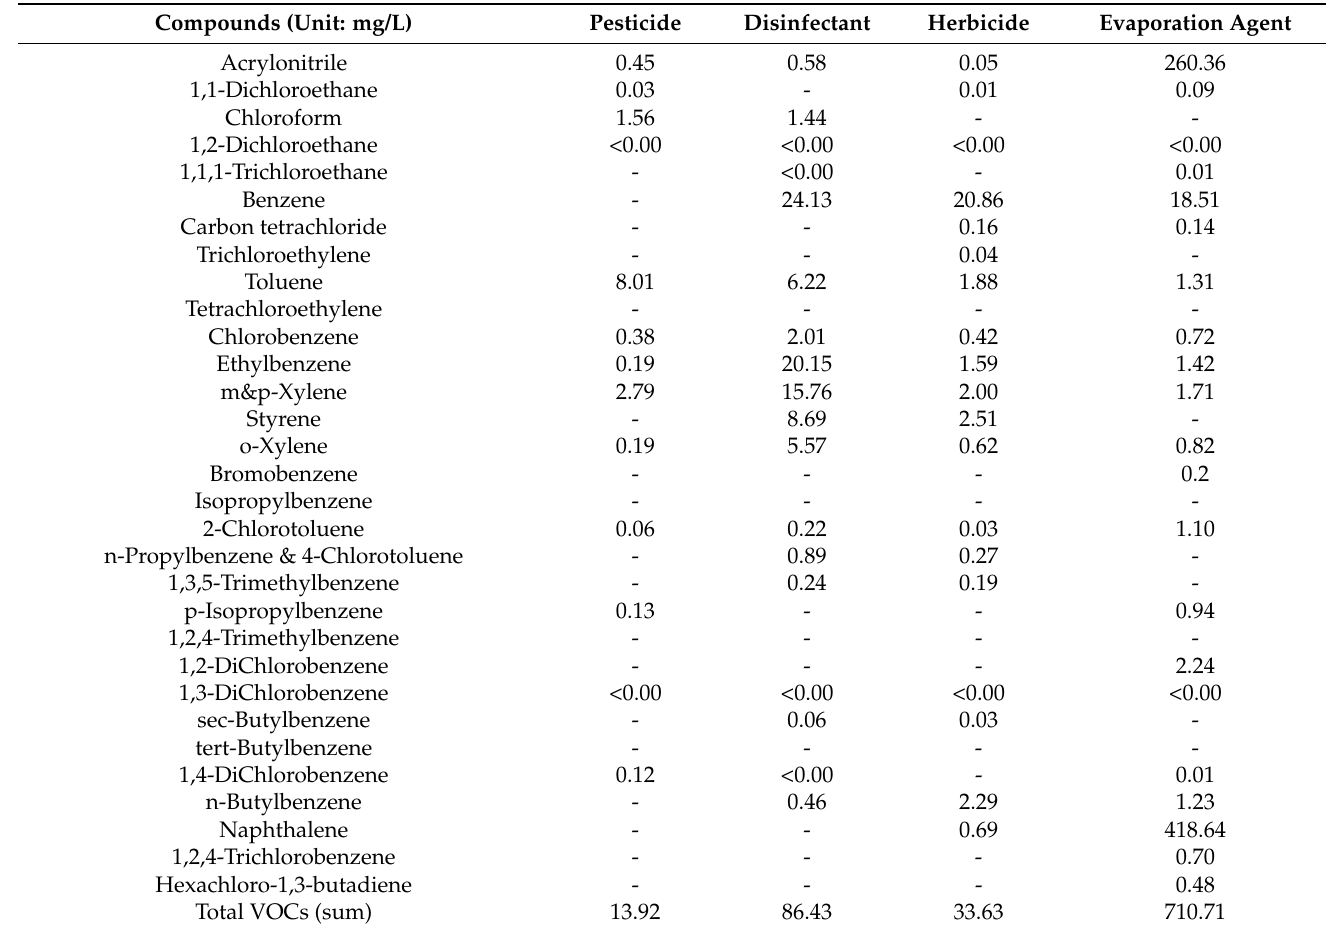
Table 1. Concentration of volatile organic compounds in the agricultural chemicals used in orchards.